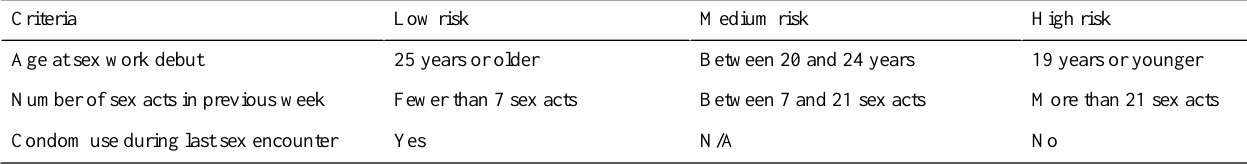
Table 2. Risk evaluation categories for female sex workers reached by the LINKAGES